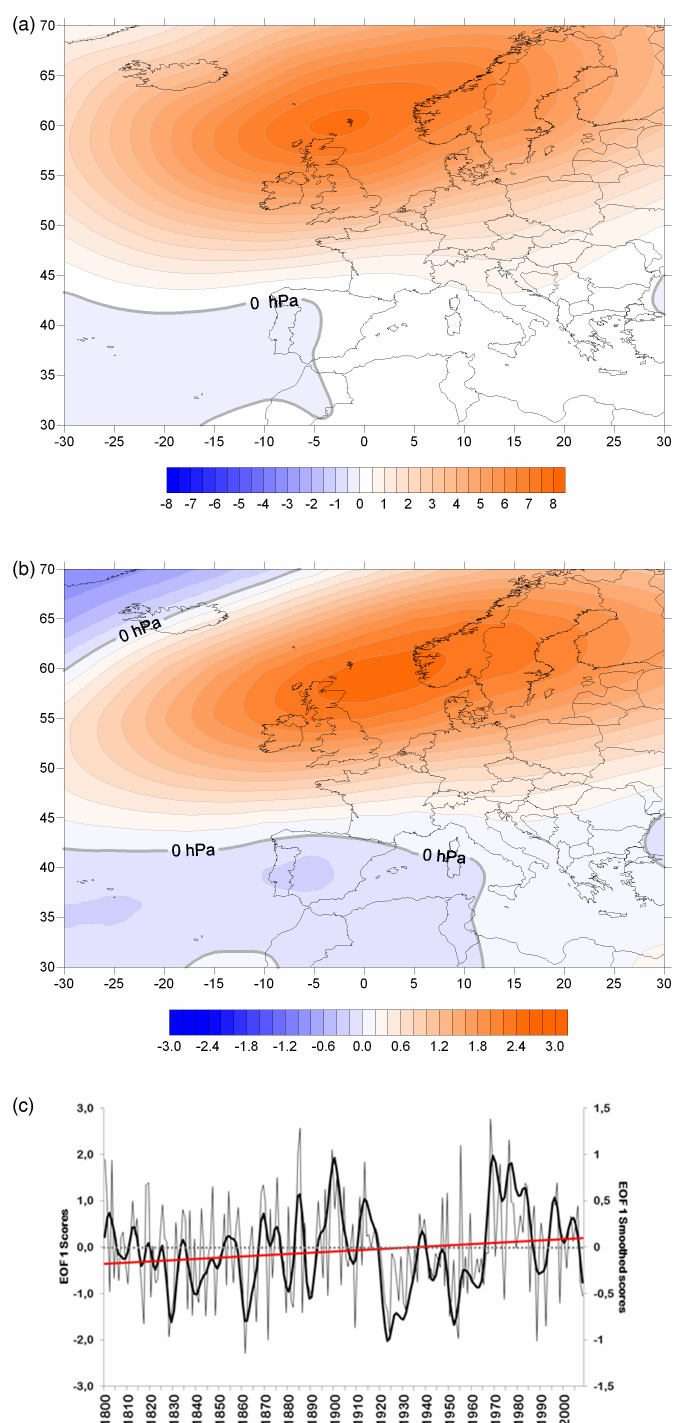
Figure 6. (a) Principal mode of low-frequency atmospheric variability based on principal eigenvector extracted from PCA in S mode, using the covariance matrix of monthly EMSLP for the period 1871–2009 (EOF1). This has been applied to the grid extracted of the 20th Century Reanalysis project (Compo et al., 2011). The red (blue) contours show positive (negative) anomalies. (b) As in (a) but applied to the monthly EMSLP of the Luterbacher reanalysis grid (Luterbacher et al., 2002) for the period 1800–1999. (c) Time series of the EOF1 pattern for the period 1800–2009 (thin black line) smoothed by a low-pass Gaussian filter of 11 years (black line). The red line shows the trend of the EOF1 time series (significant and positive trend at a 95% confidence level, p value =